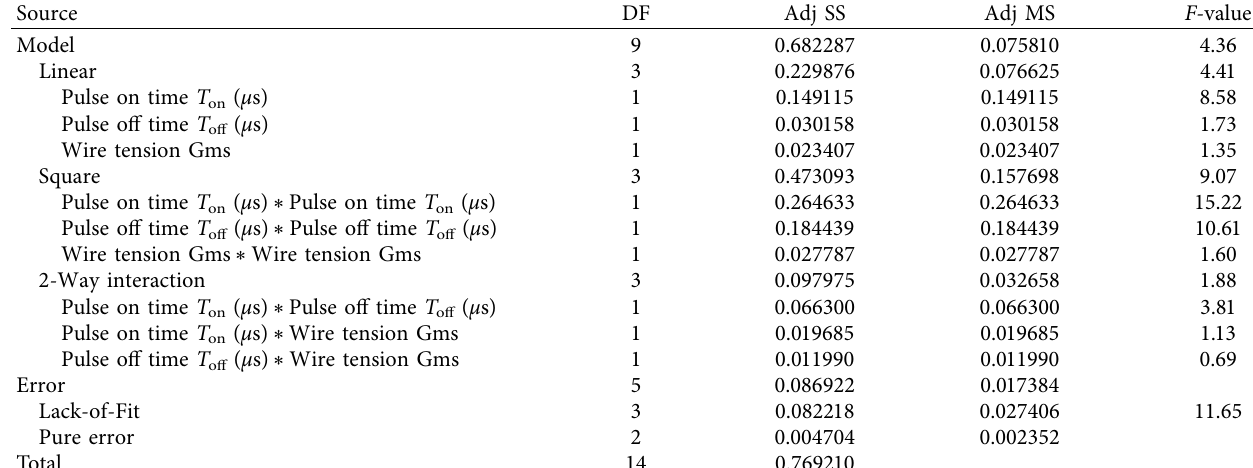
Table 3: Analysis of variance-MRR.